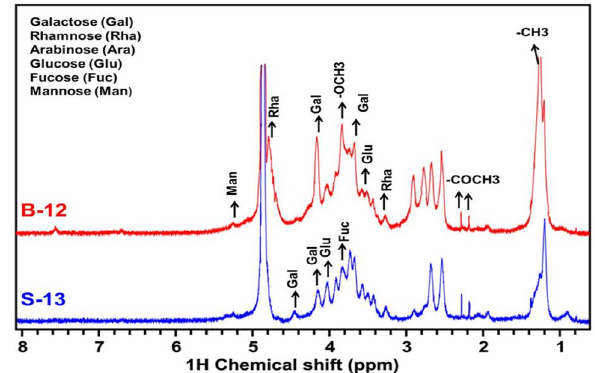
Figure 2. NMR spectra of mulberry Pectin: BR-2 and S-13 varieties.